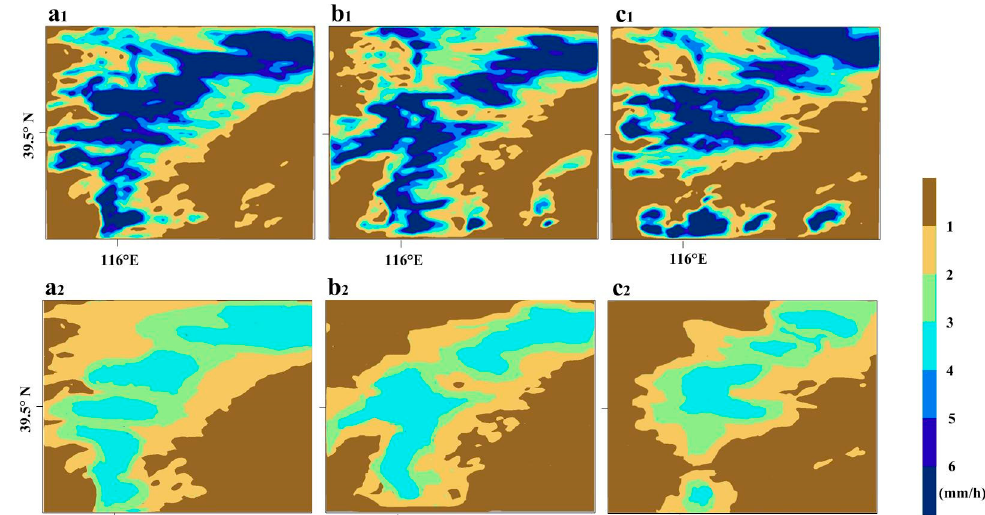
Figure 7. Comparison of peak rainfall. (( a 1 , b 1 , c 1 ) are peak rainfall of NU, CU, and FU during the first rainfall event (20–21 July), respectively; ( a 2 , b 2 , c 2 ) are peak rainfall of NU, CU, and FU during the second rainfall event (July 25)).